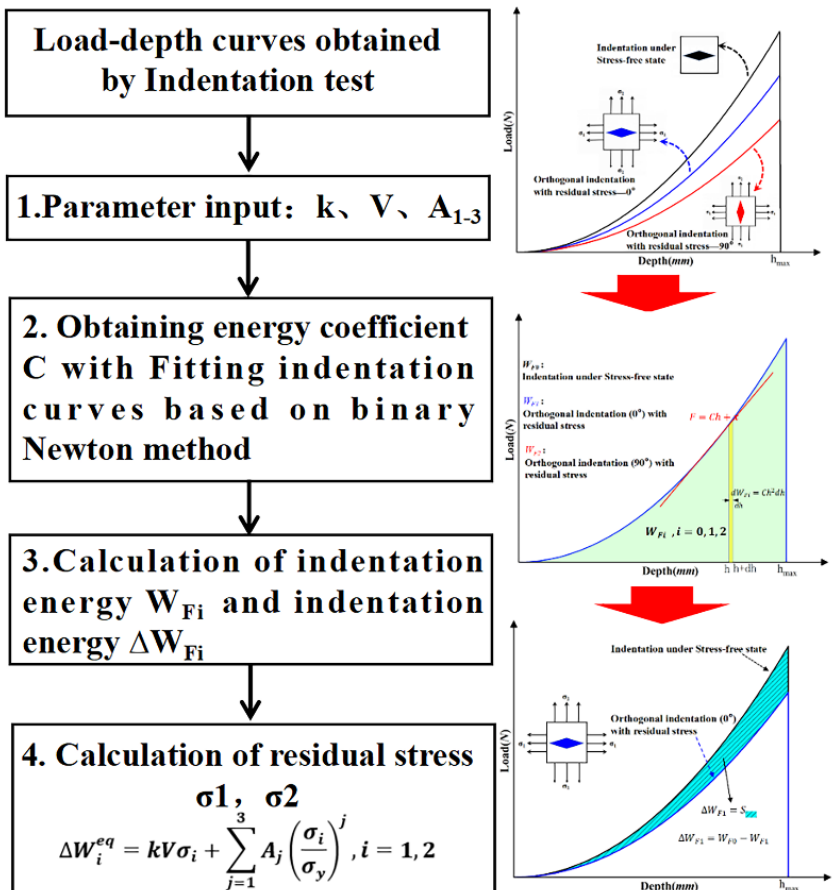
Figure 4. Flow chart of biaxial residual stress algorithm.